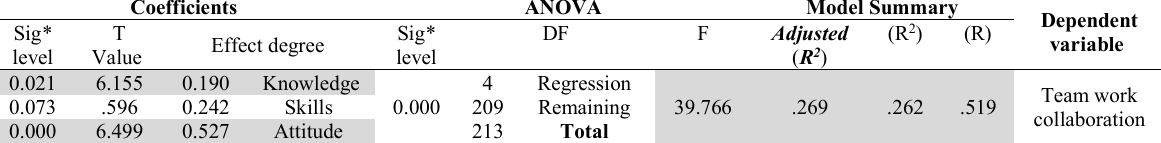
The summary of the effect of job competencies on team work collaboration